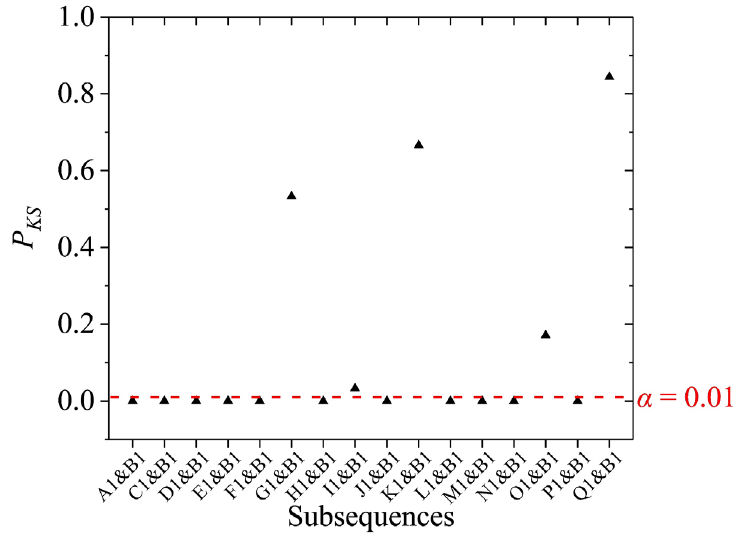
Figure 7. Results of the two-sample KS test of the subsequences segmented by the signal 1.